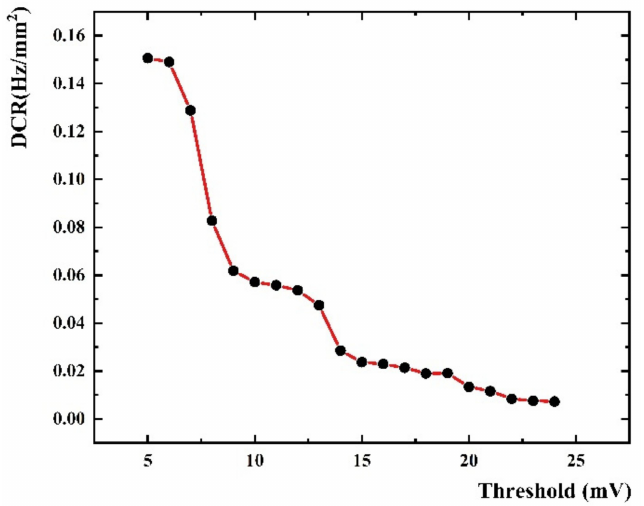
Figure 8. DCR vs. threshold with 6 V over voltage at liquid nitrogen